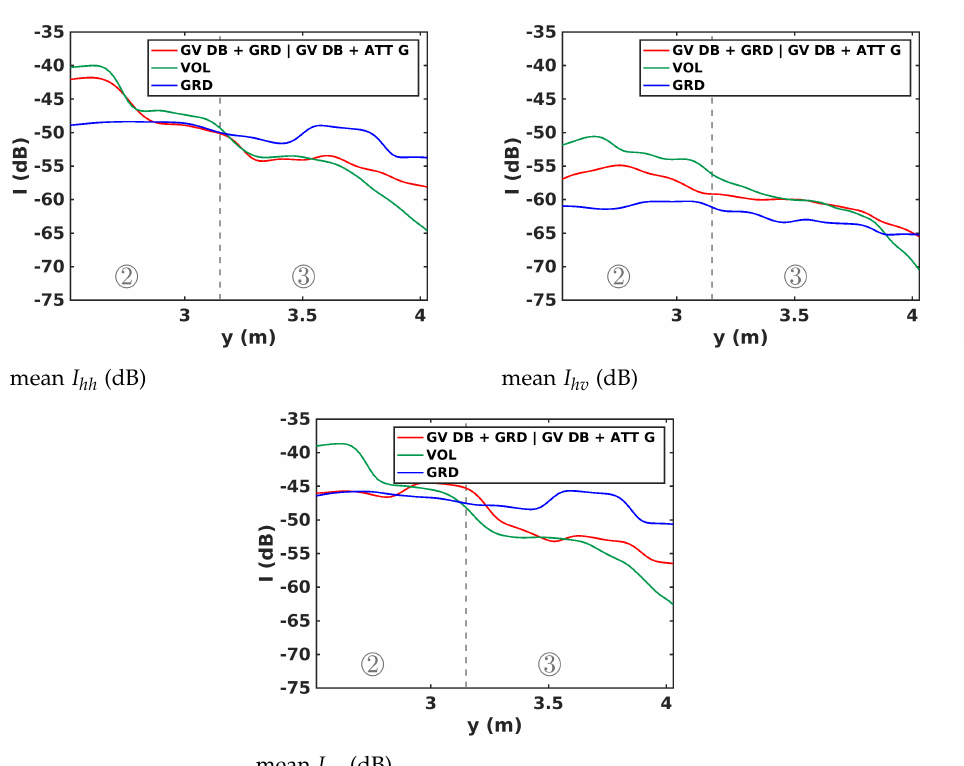
Figure 15. Mean intensity comparison between volume, underlying ground and bare ground. Dashed lines represent the borders between the indexed